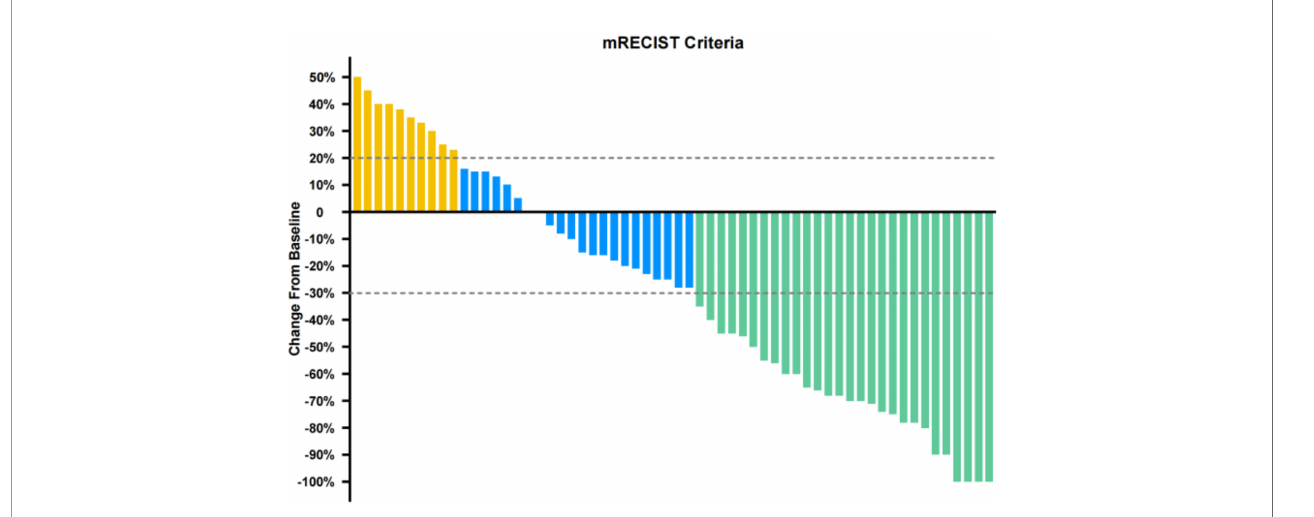
FIGURE 1 | Percentage changes from baseline (summed diameters of target tumors by mRECIST).